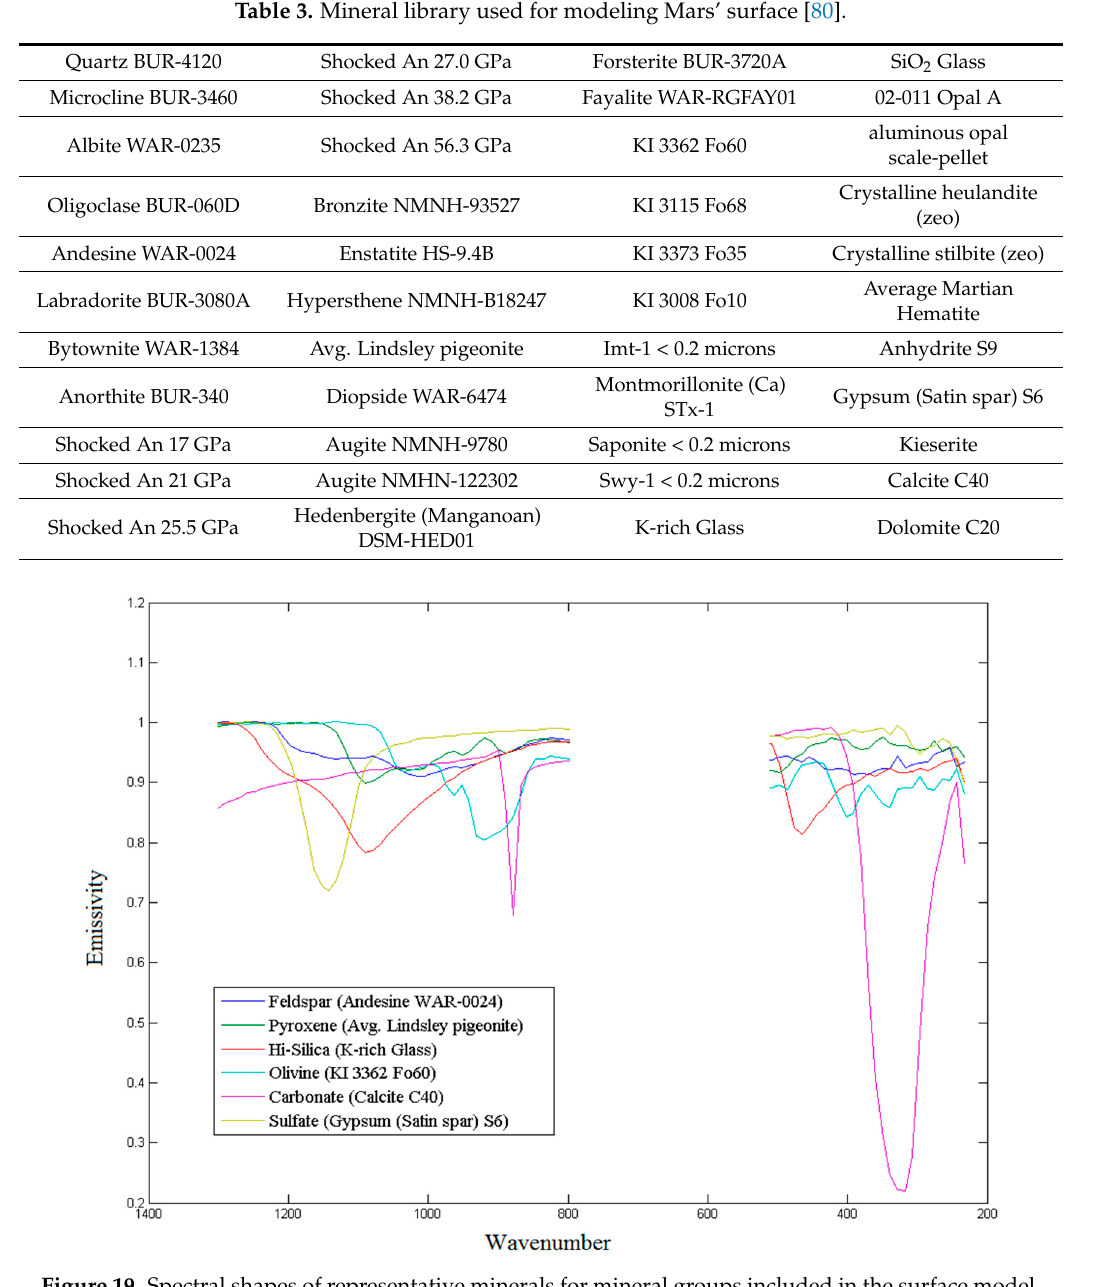
Table 3. Mineral library used for modeling Mars’ surface [80].